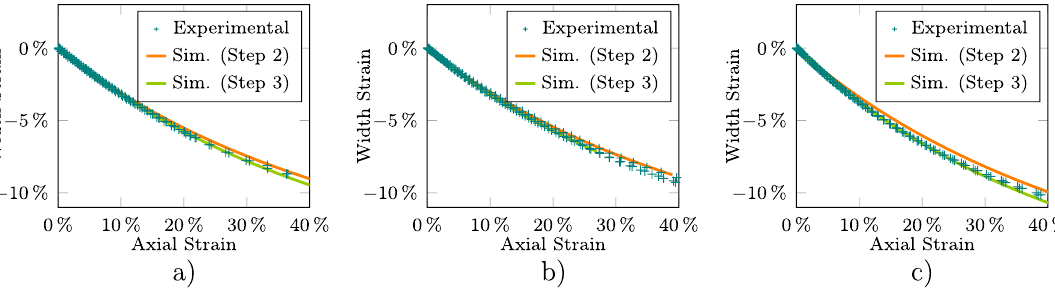
Figure 9. Fitting of the Hill-48 yield and flow potential functions from the average experimental σ eng - ε eng curve for the ( a ) RD, ( b ) DD, and ( c ) TD tensile